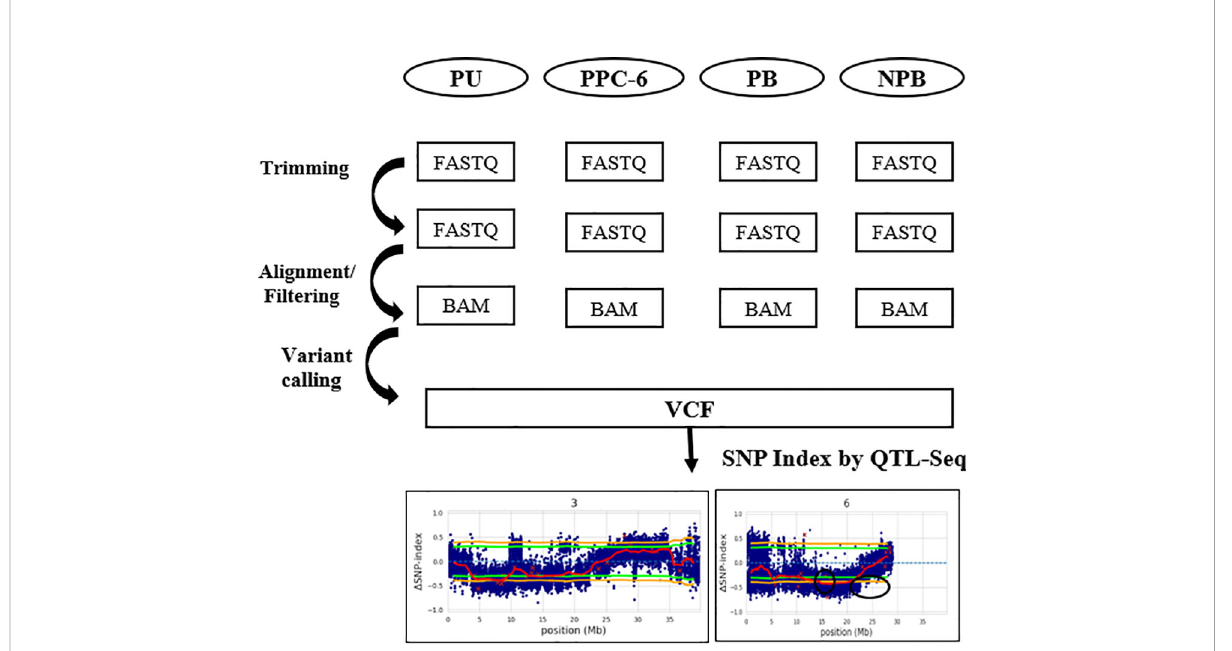
FIGURE 2 Schematic representation of the pipeline used for the QTL- Seq